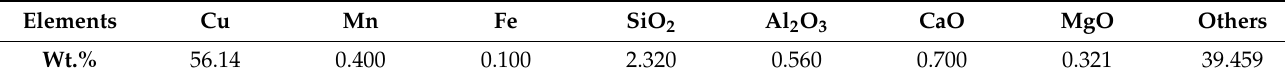
Table 1. The analysis of malachite composition by XRF.